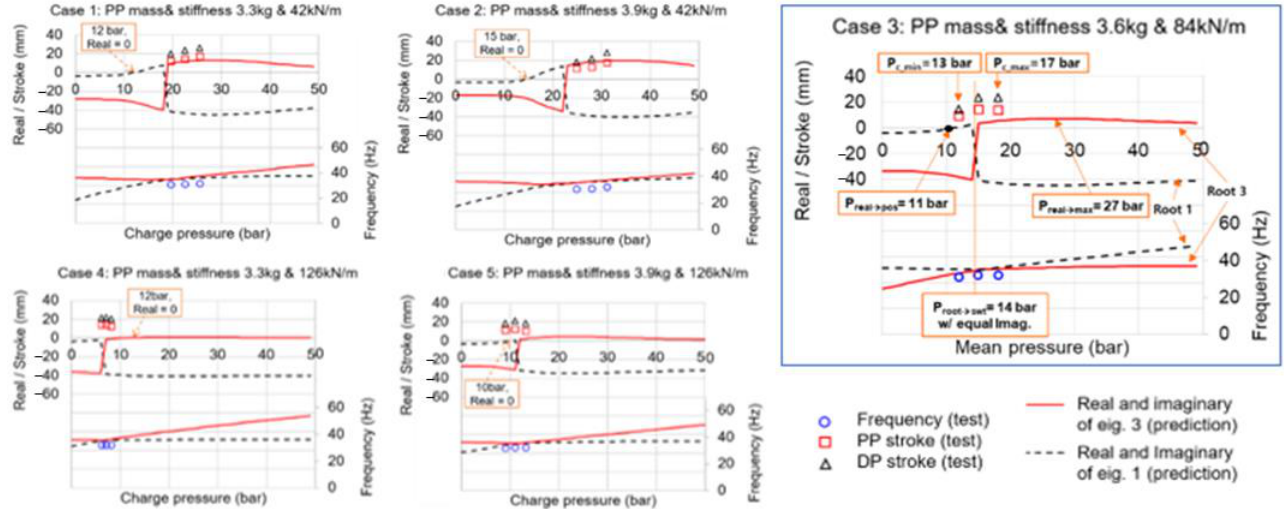
Figure 10. Comparison of root locus analyses with experiments for cases 1–5. The real and imaginary parts of the upper pole (eigenvalue 1, 3) with increasing charge pressure of 0–50 bar (prediction) and the operable pressure ranges, the frequency, and the two piston strokes (experiment) are given.